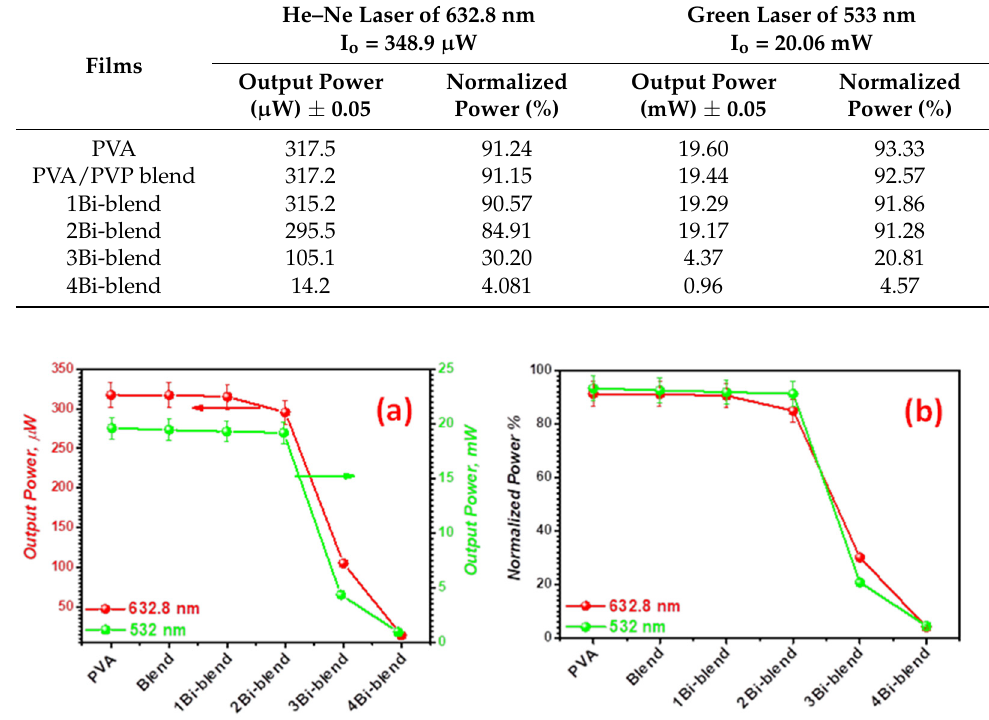
Figure 14. ( a ) Output power, and ( b ) normalized power for Bi-blend hybrid films.